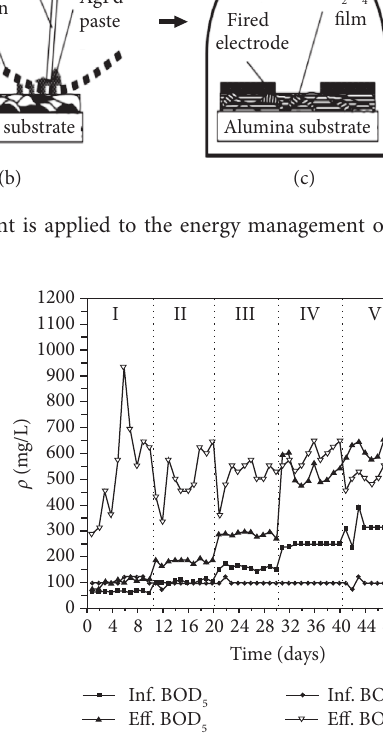
Figure 12: Precision instrument of watt-hour meter tester with fault in transmission